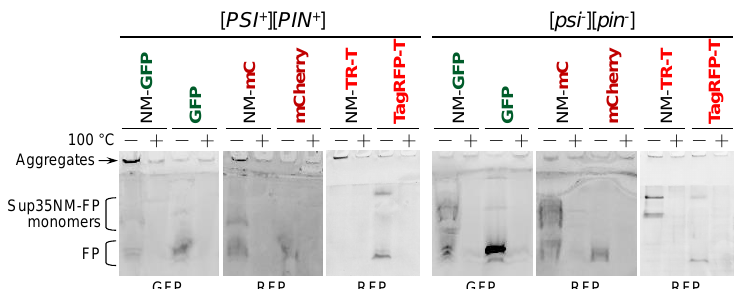
Figure 4. Sup35NM-mCherry degradation leads to decrease in relative amount of aggregates detectable by fluorescence. Proteins from OT56 ([ PSI + ] [ PIN + ]) or 2-OT56 ([ psi - ] [ pin - ]) cells expressing indicated constructs were extracted in non-denaturing conditions. After addition of the SDS-containing buffer, samples were either boiled for 5 min (+) or incubated at room temperature ( − ). SDS-PAGE was visualized using a gel documentation system with filter sets for either green (GFP) or red (RFP)